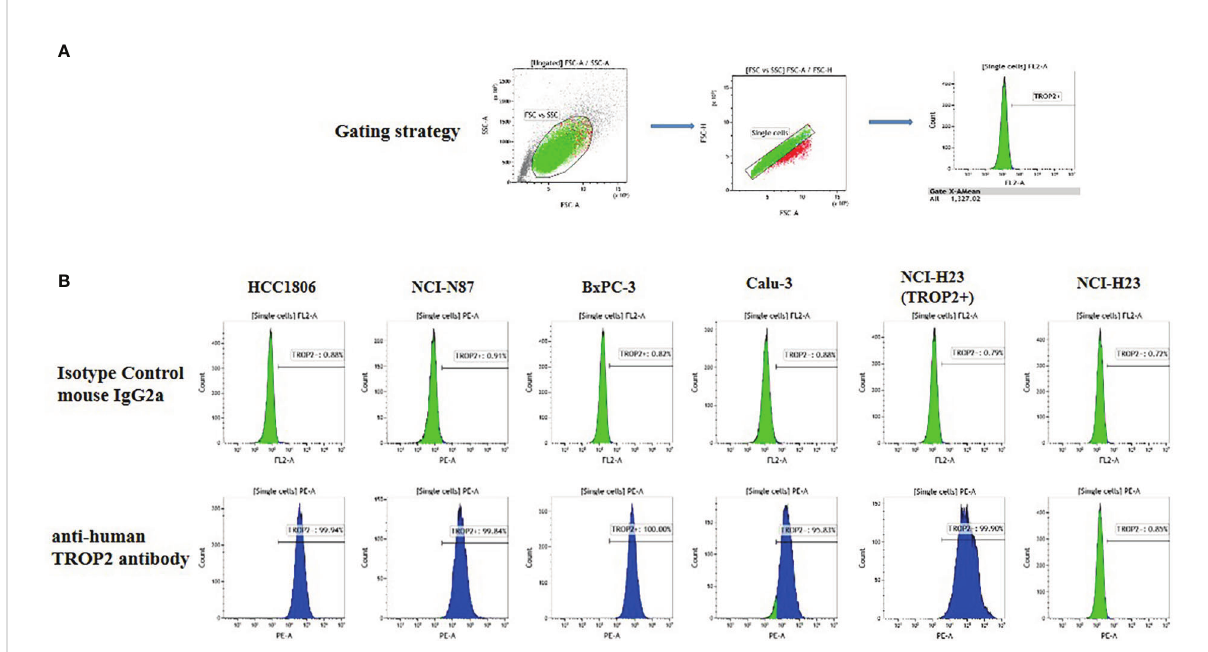
FIGURE 3 TROP2 expression on the cell surface. (A) Gating strategy. (B) FACS measurement results for six cell lines, namely, HCC1806, NCI-N87, BxPC-3, Calu-3, NCI-H23 (TROP2+), and NCI-H23